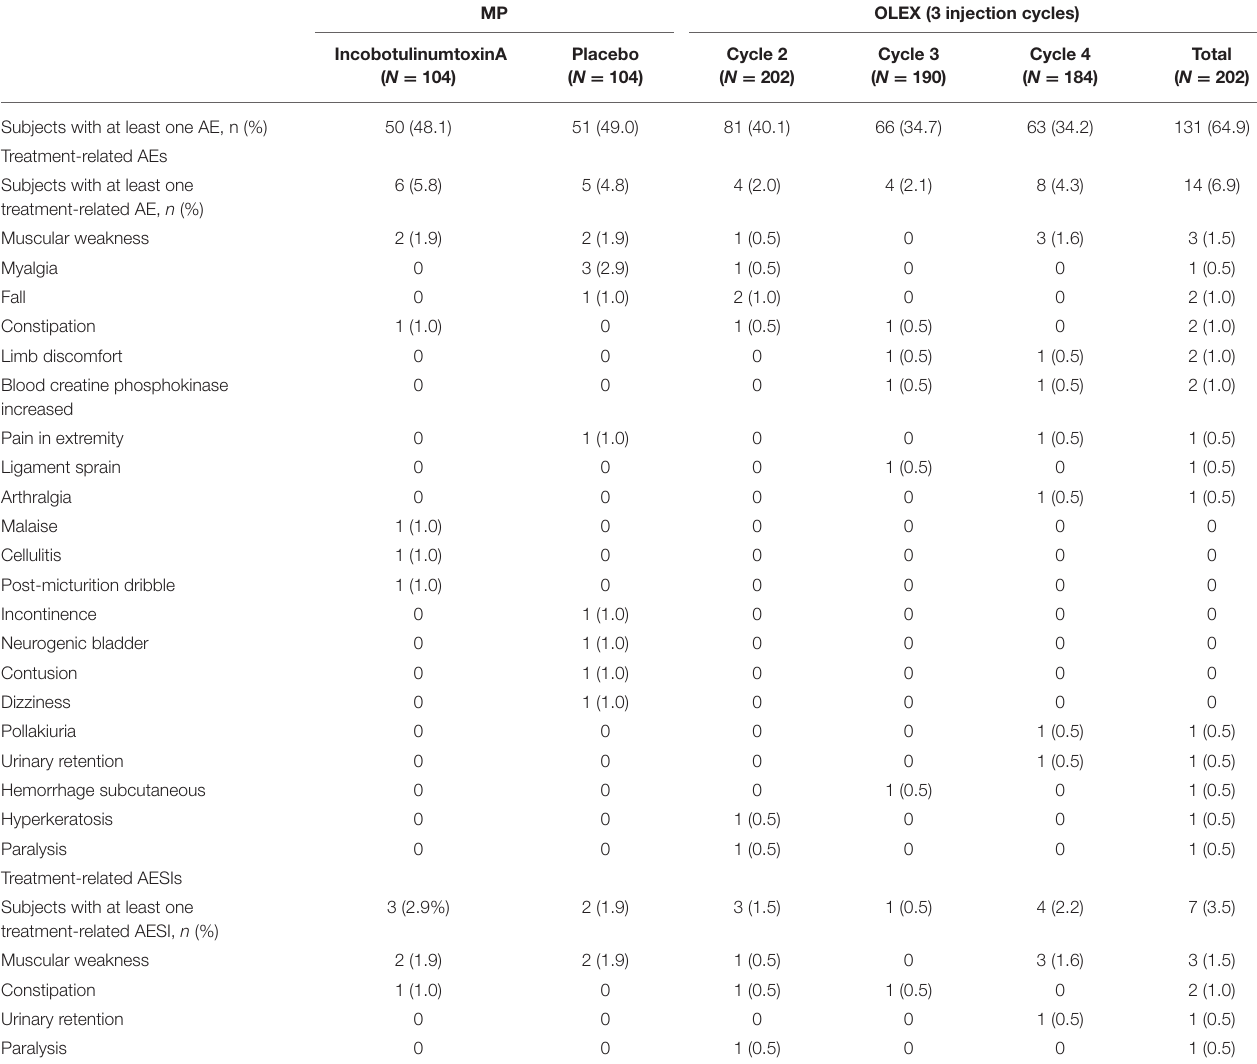
TABLE 3 | Treatment-related AEs reported in MP and OLEX by preferred term